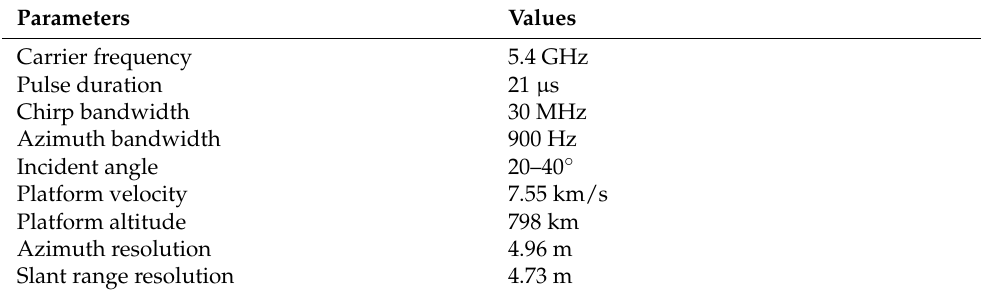
Table 2. The parameters of the quad-polarization RADARSAT-2 SAR.